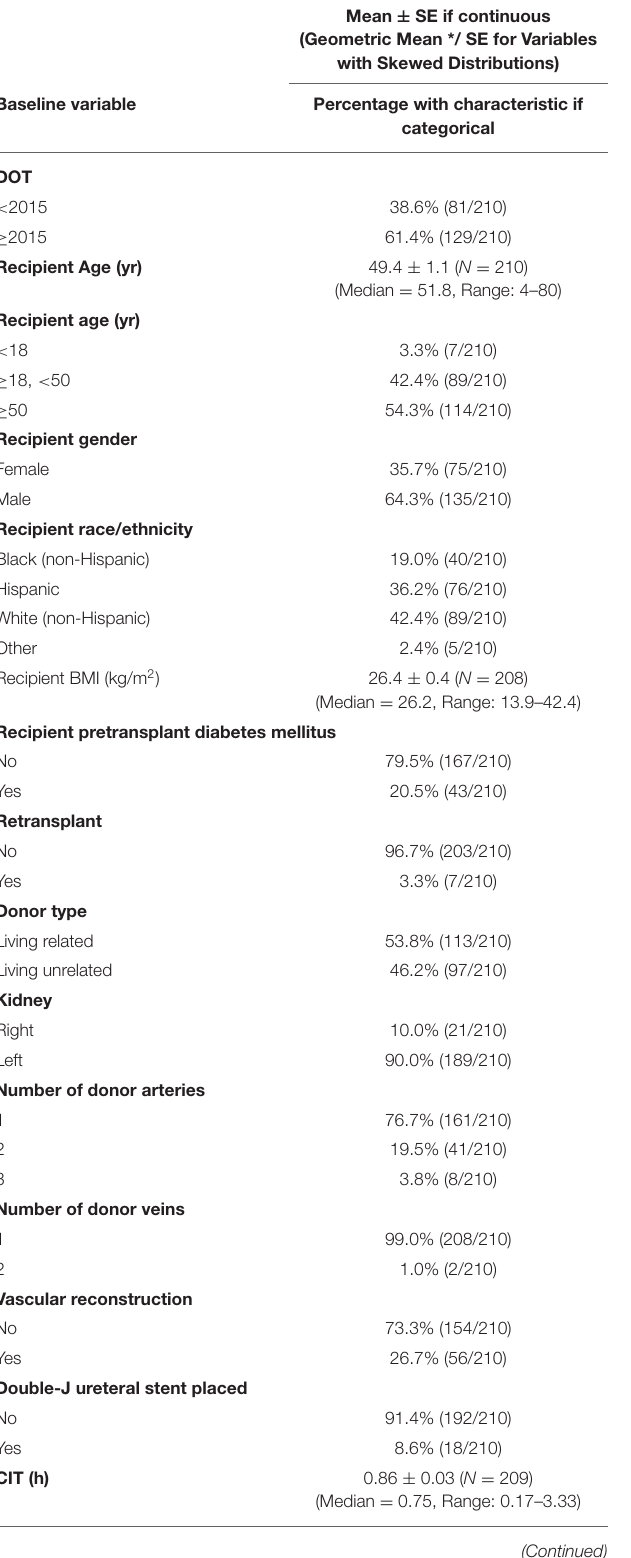
Mean ± SE if continuous (Geometric Mean */ SE for Variables